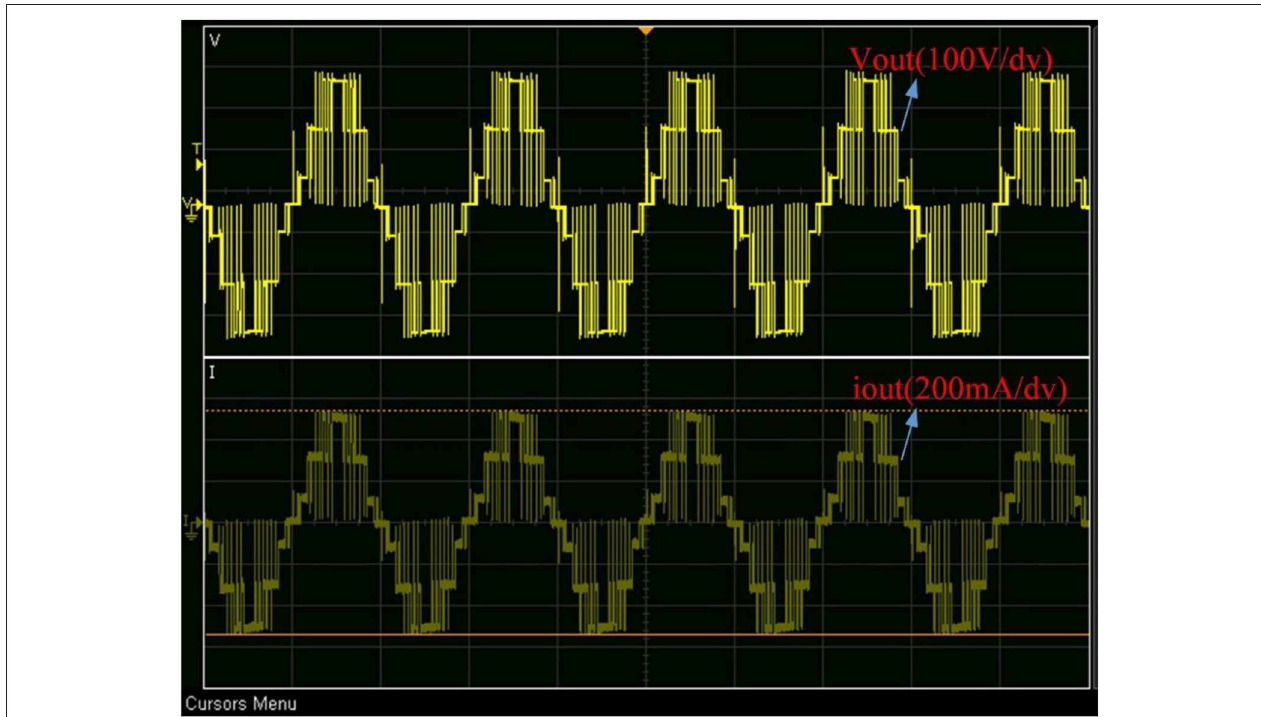
FIGURE 12 | Output voltage and current of seven-level inverter with five switches.